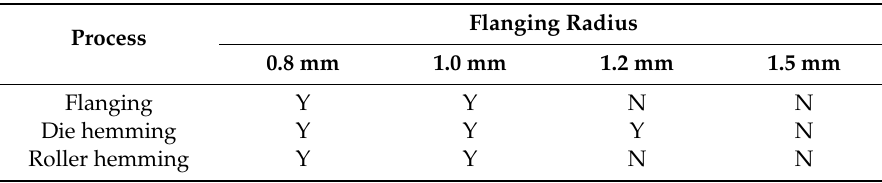
Figure 15. Experimental and simulation results based on different R f in the roller hemming process. Table 3. Formability experimental results of 6014-T4.